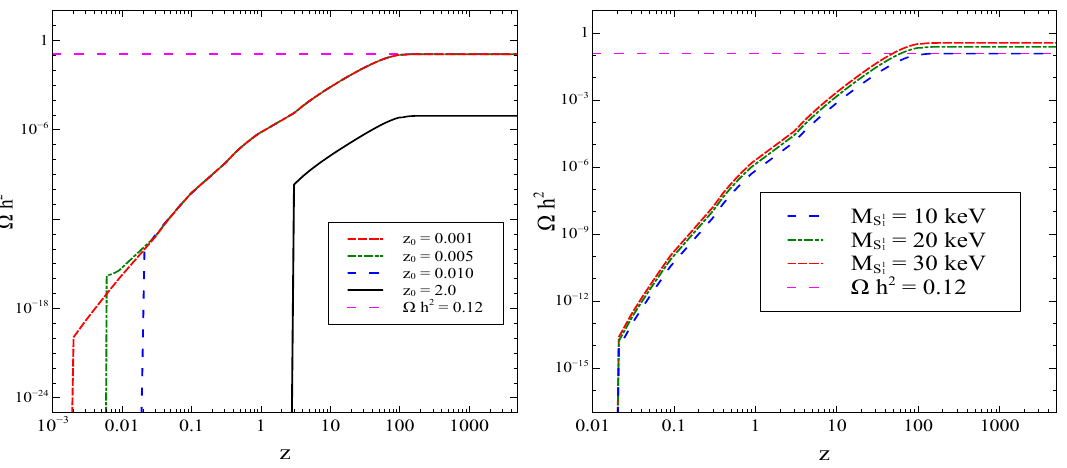
Figure 2 . Variation of DM relic density, for the decay contribution only, as a function of z for di(cid:11)erent values of z 0 (left), where M where z 0 = 0 : 01. Here g 0 = 12 : 5 (cid:2) 10 (cid:0) 10 , M Z 0 = 10 GeV, M h